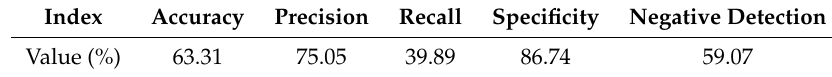
Table 27. Detection evaluation indices.